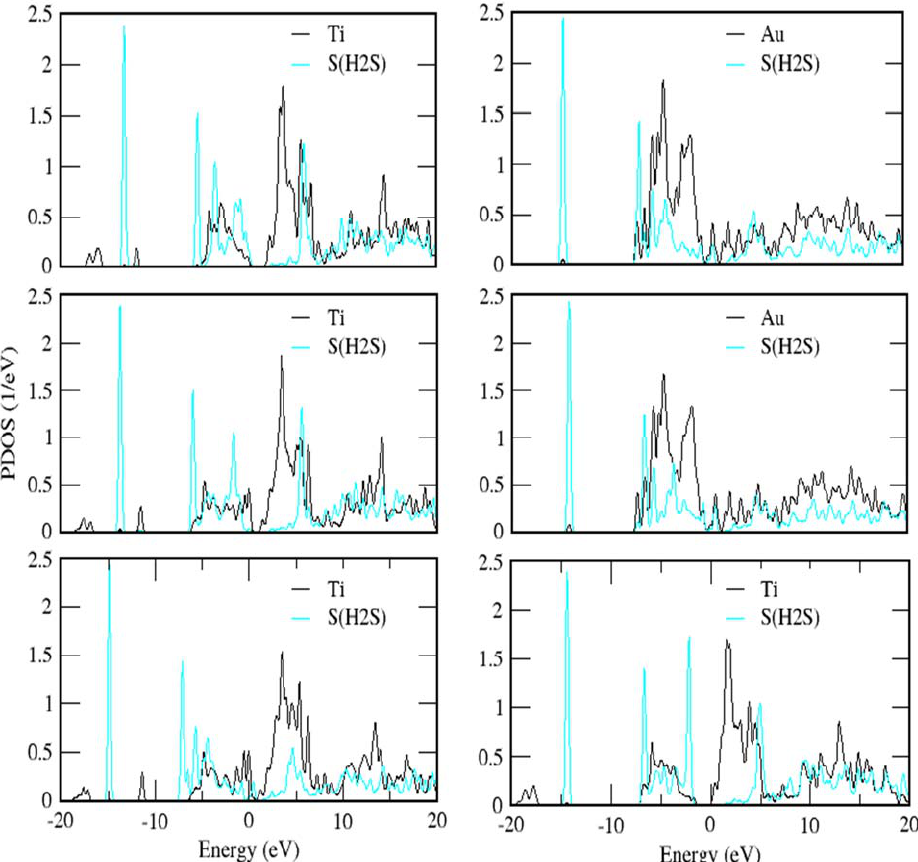
Fig. 5. PDOS for the adsorption complexes of H C; d: Complex E; e: Complex D and f: Complex